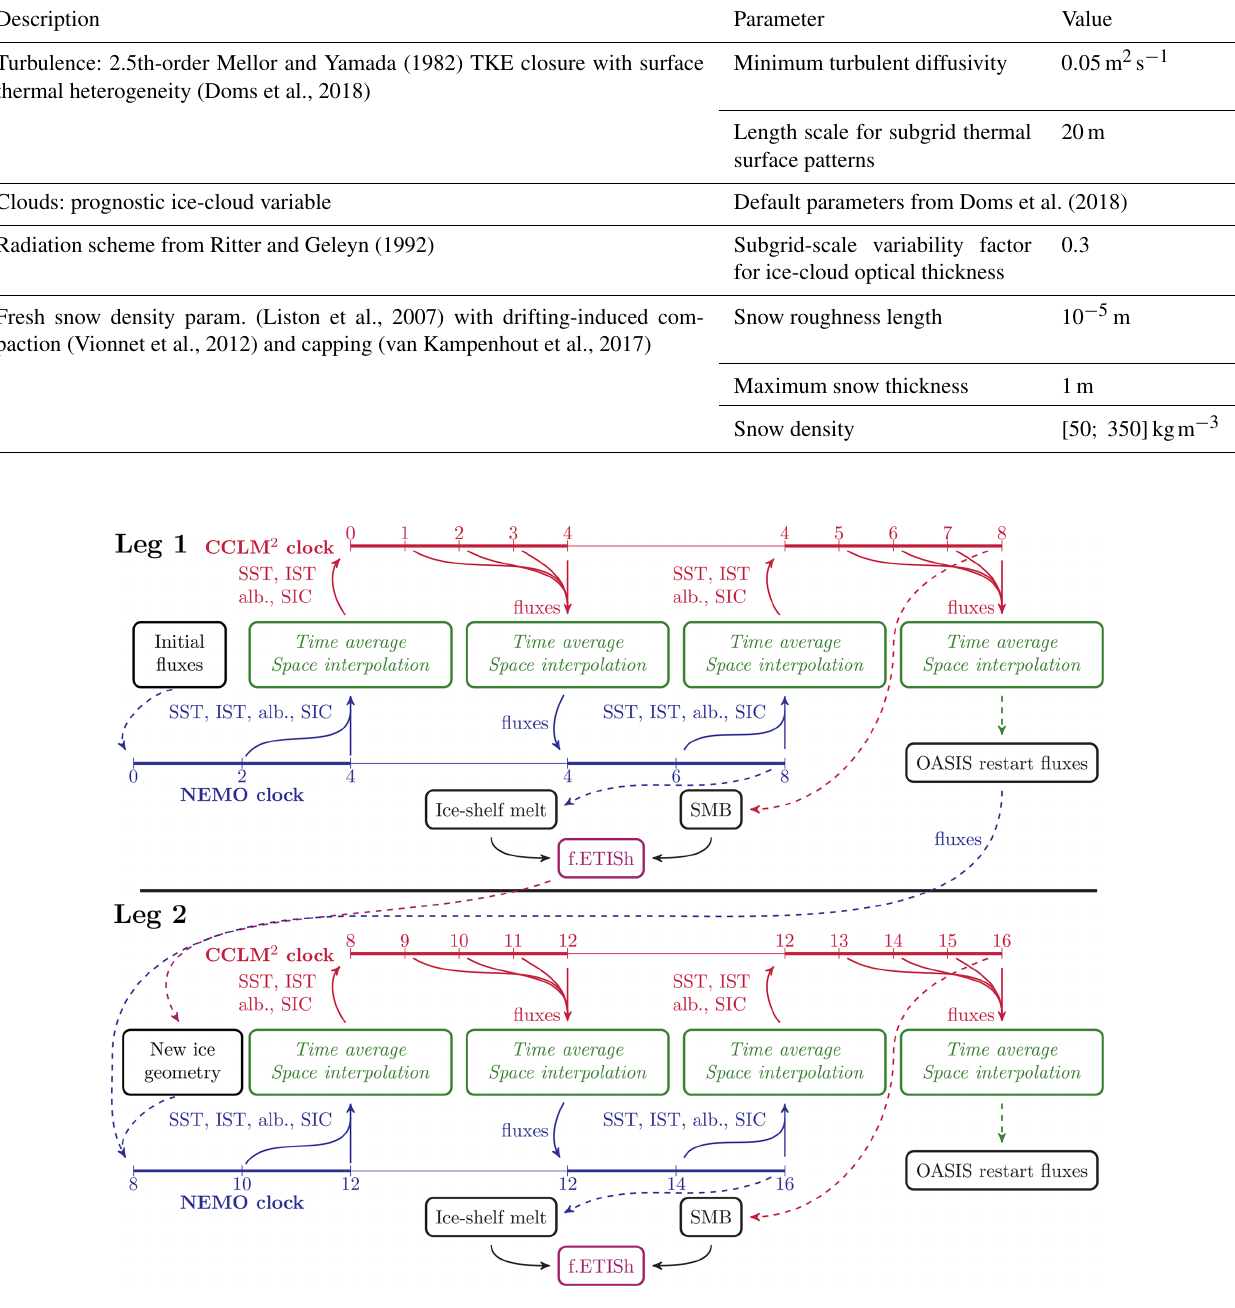
Figure A1. Fully coupled system timing scheme. Here, two restart legs are represented, separated by the thick horizontal line. The top and bottom timelines represent the NEMO and CCLM physical clocks, respectively. They are deliberately staggered to account for NEMO receiving delayed fluxes. For the sake of readability, above the CCLM, the time step is 1, NEMO’s is 2, the NEMO–CCLM coupling frequency is 4 and the ice-sheet model coupling frequency is 8. In between legs, the NEMO–CCLM system is stopped. Black boxes represent data written on the disk. Green boxes represent OASIS operations. Full arrows represent exchange of data between models and OASIS. Dashed lines represent reading or writing to disk. “SST” stands for sea surface temperature; “IST”, ice surface temperature; “alb.”, albedo; “SIC”, sea-ice concentration; “SMB”, surface mass